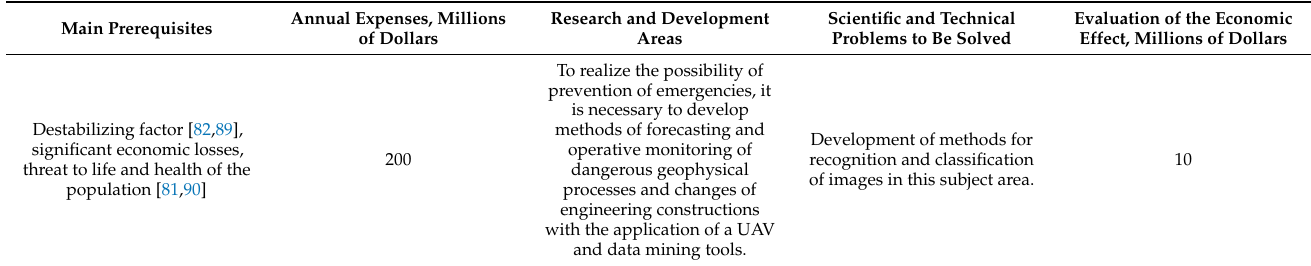
Table A6. IUAVT use for monitoring hazardous geophysical processes.